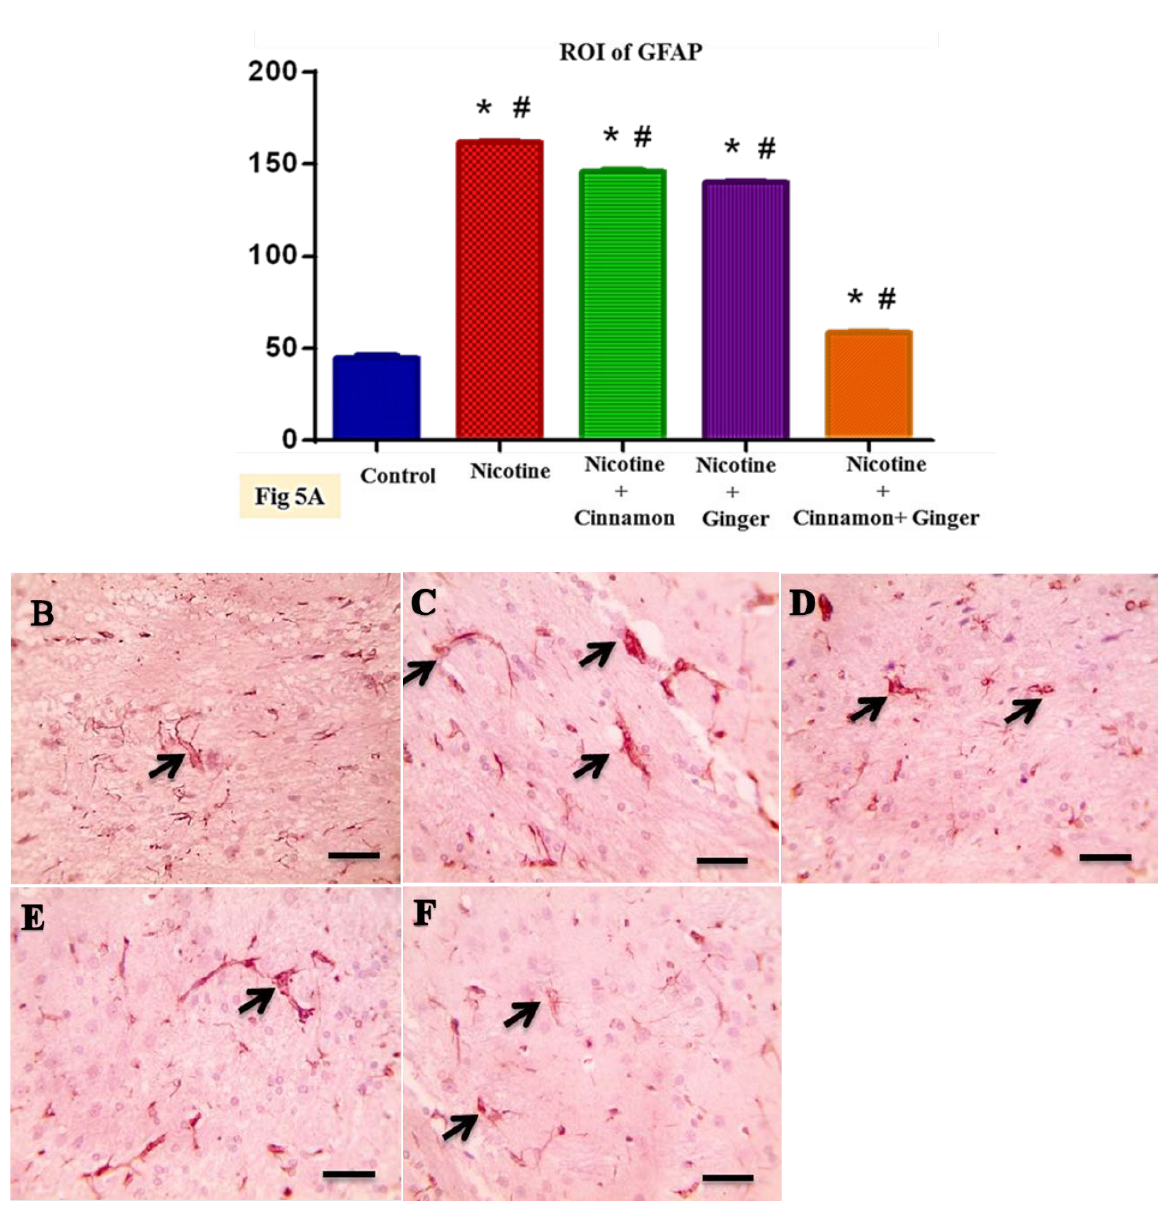
Figure 5. The expression of GFAP by immunostaining in different groups. ( A ) Graphs of ROI of the expression of GFAP in different groups. ( B ) Brain specimens showing mild expression of GFAP in astroglial cells of prefrontal cortex (black arrow) (control group). ( C ) Marked strong positive brownish reaction of GFAP in prefrontal cortex astroglial cells (black arrows) (nicotine group). ( D , E ) Moderate expression of GFAP in prefrontal cortex glial cells (black arrows) (nicotine + cinnamon oil and nicotine + ginger groups), and ( F ) mild expression of GFAP in prefrontal cortex astroglial cells (nicotine + cinnamon oil + ginger oil group). * Significantly different from the control group; # significantly different from other group p value = 0.05. X: 400 bar 50.